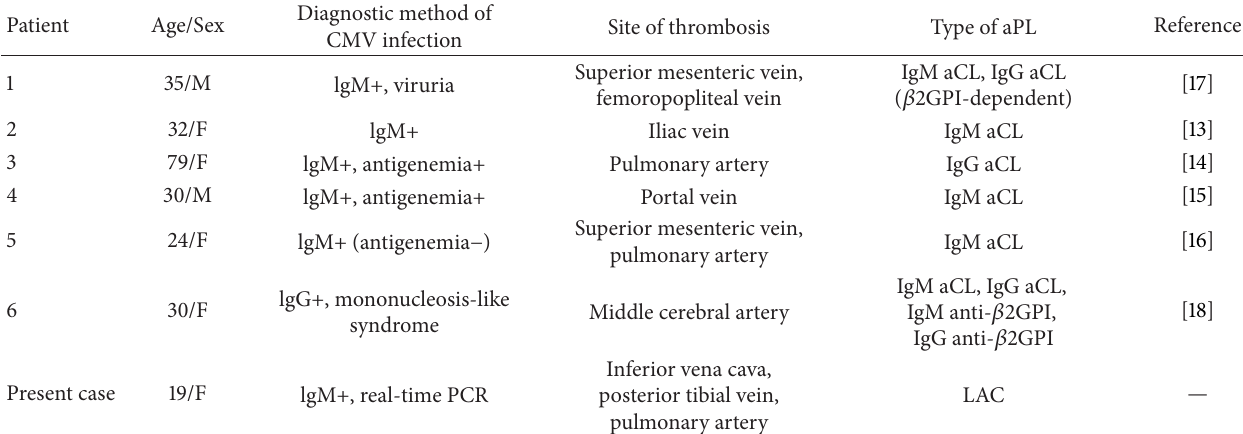
Table 3: Characteristics of patients with CMV infection and vascular thrombosis associated with